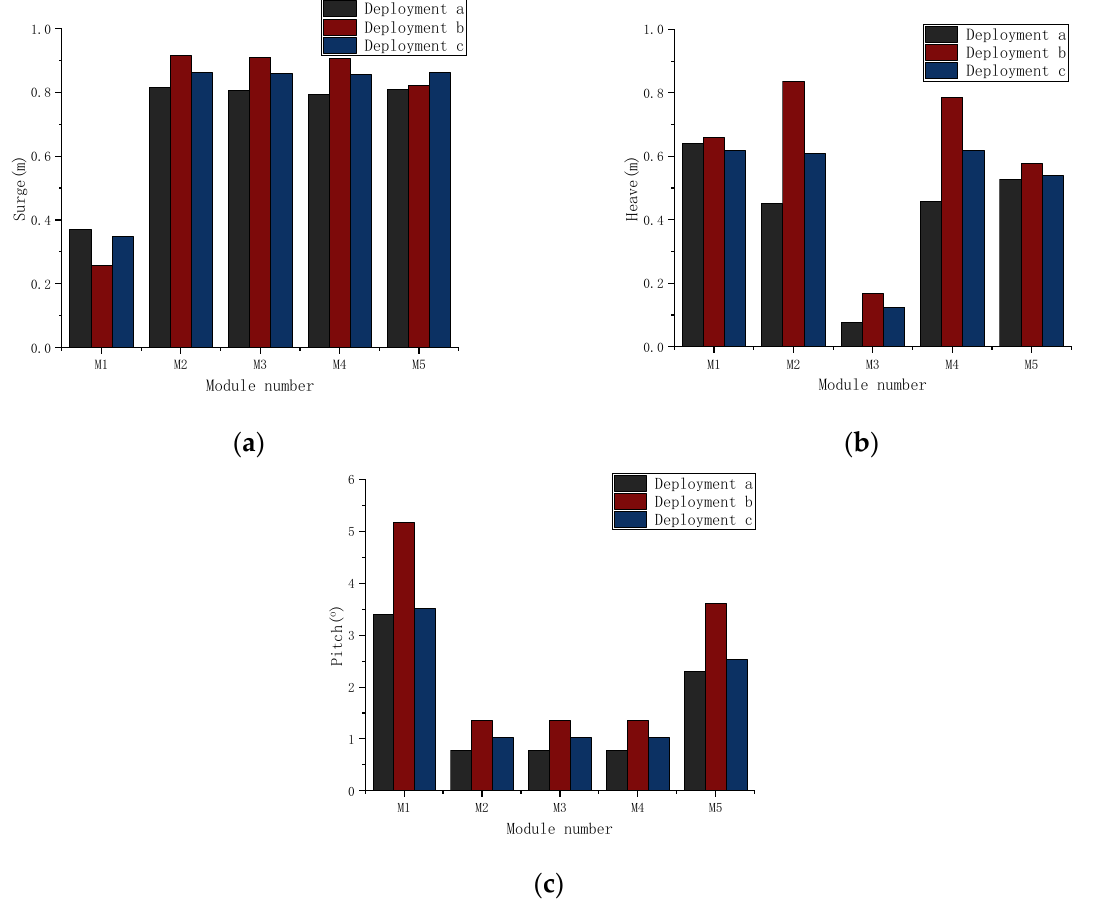
Figure 3. Dynamic responses of each module with three deployments: ( a ) surge; ( b ) heave; and ( c ) pitch. ( c )